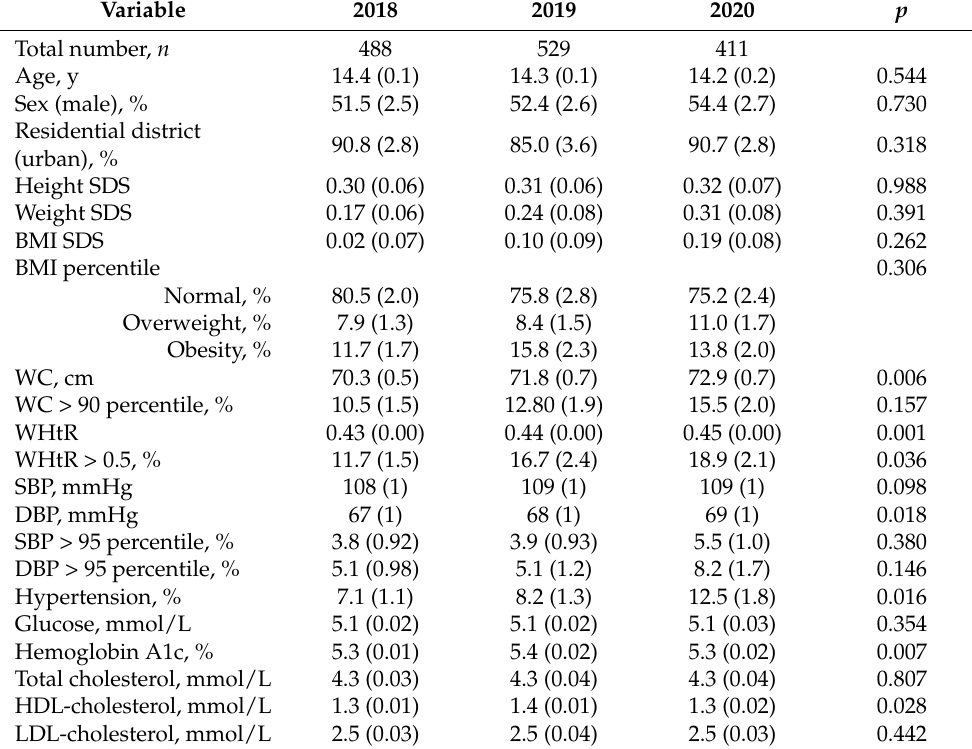
Table 2. Proportion of participants with obesity, abdominal obesity, and hypertension according to sex.